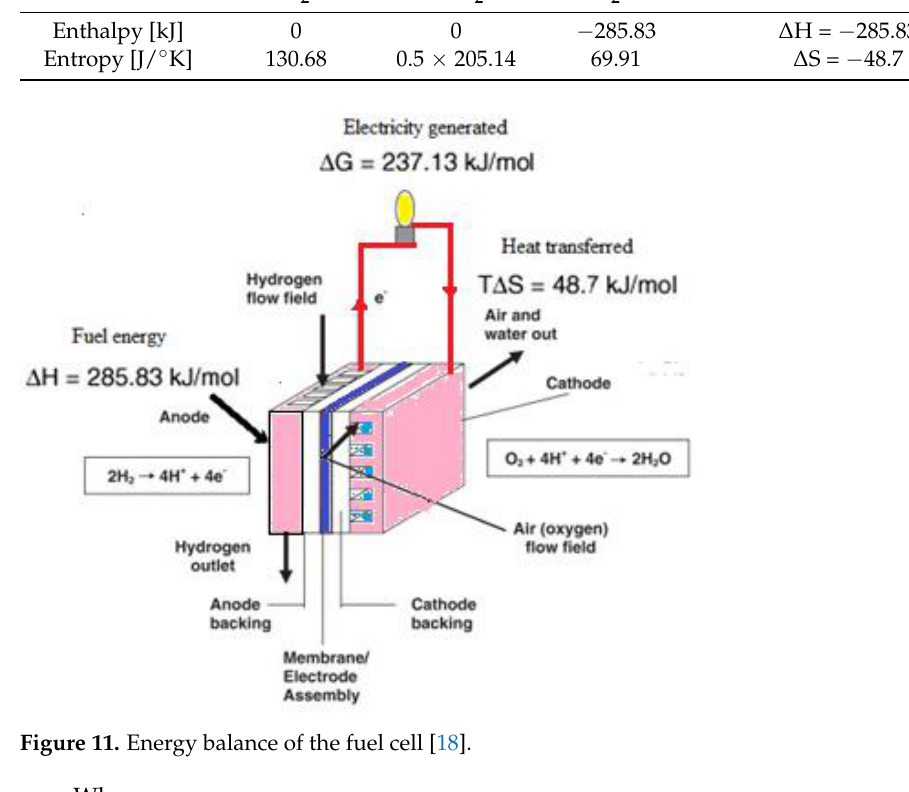
Figure 11. Energy balance of the fuel cell [18]. Table 3. Transformations in the fuel